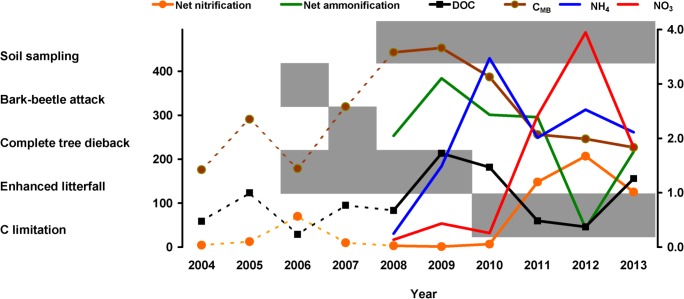
A simplified scheme of the main changes in C and N cycling along with the timeframes of major ecosystem changes (grey fields) at the Plešné plot, affected by the bark beetle infestation.The lines show mass weighted means of spring values of the respective variables in the O and A soil horizons. The left Y axis shows rates of net ammonification and net nitrification (μmol kg-1d-1), C in microbial biomass (CMB; mmol kg-1), and DOC concentrations in water extracts (mmol kg-1). The right Y axis shows concentrations of NH4 and NO3 (mmol kg-1) in water extracts. Values for the years 2004–2007 are based on regular annual spring samplings (late May) at the study plot (Šantrůčková, unpublished data). Similar scheme for unaffected CT plot is given in SI (S4 Fig).